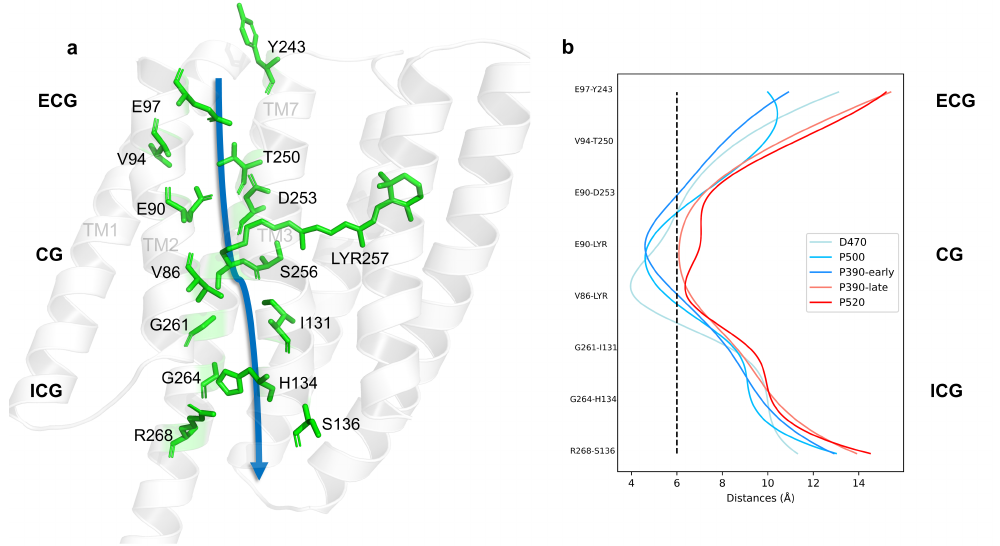
Figure 2. The outline of the ion channel in ChR2. ( a ) Key residues that forms the channel in ChR2. ( b ) The distances of inter-helix residue pairs along the channel. The vertical black dash line represents the experimental radius of an open